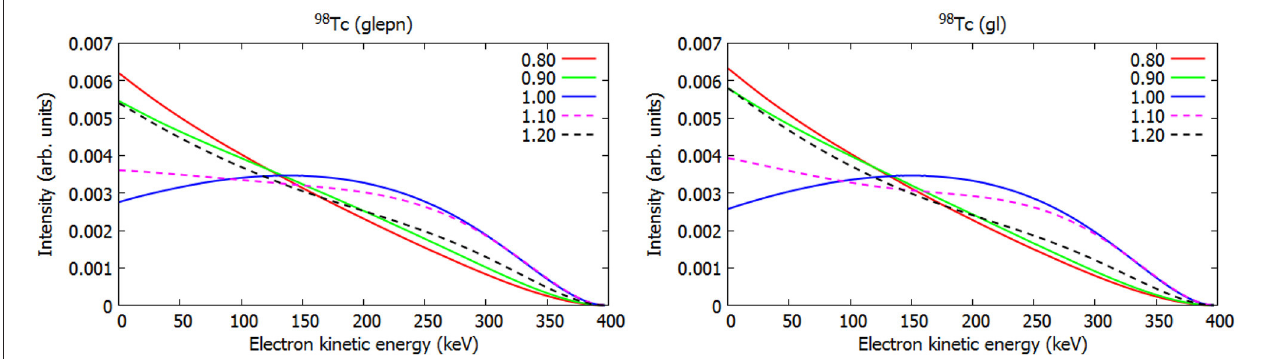
98 Ru(4 + ) using two different Hamiltonians. →